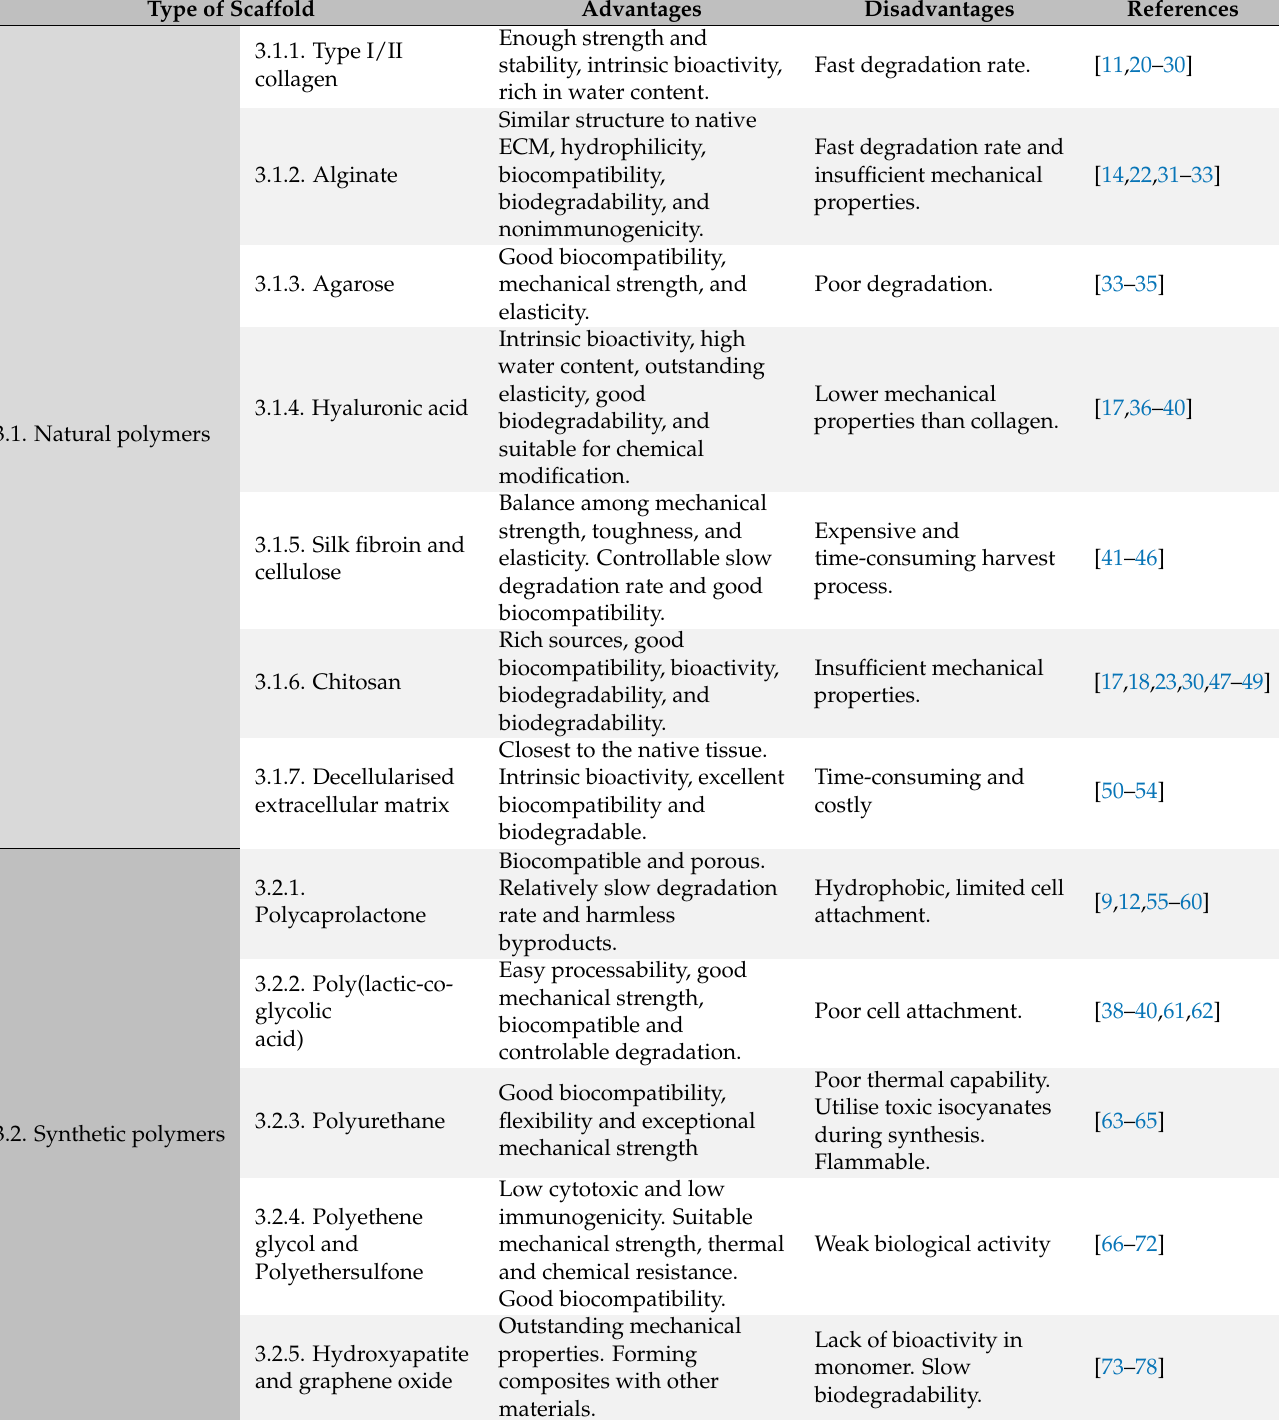
Table 1. Summary of advantages and disadvantages of natural and synthetic